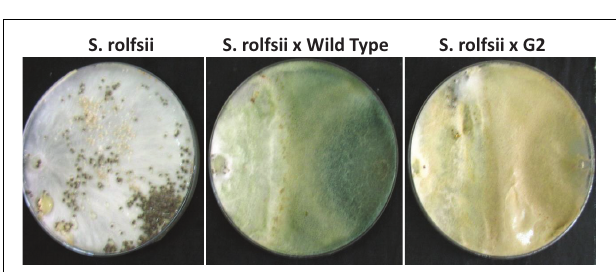
FIGURE 4 | Parasitism of sclerotia of Sclerotium rolfsii by wild type and mutant of Trichoderma virens . (A) Sclerotia colonized after 5 days of co-incubation of Trichoderma and sclerotia of S. rolfsii . (B) Growth of S. rolfsii from sclerotia after 3 days of incubation on benomyl-amended PDA medium.